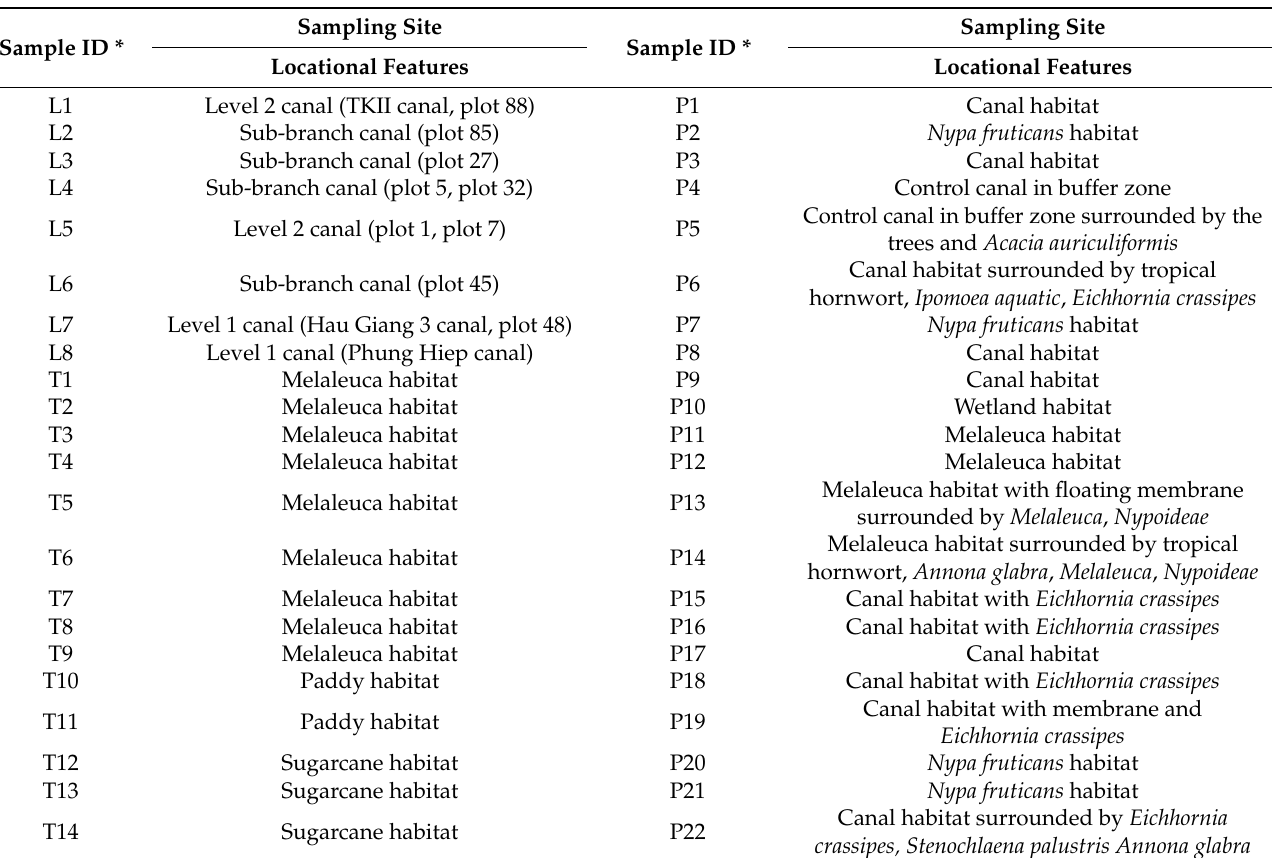
Table 1. Sample Location Specifications with Global Positioning System (GPS) coordinates. Seasonal samples were collected in 2016 and